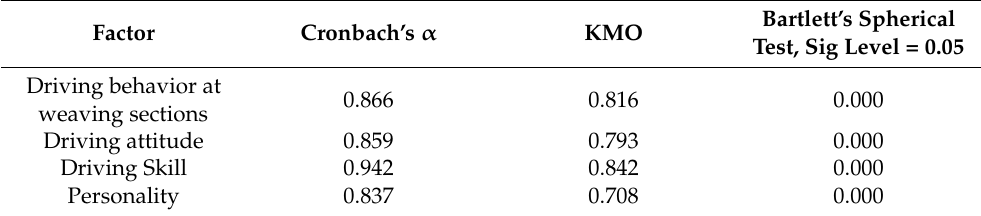
Table 2. The reliability and validity test of questionnaire.